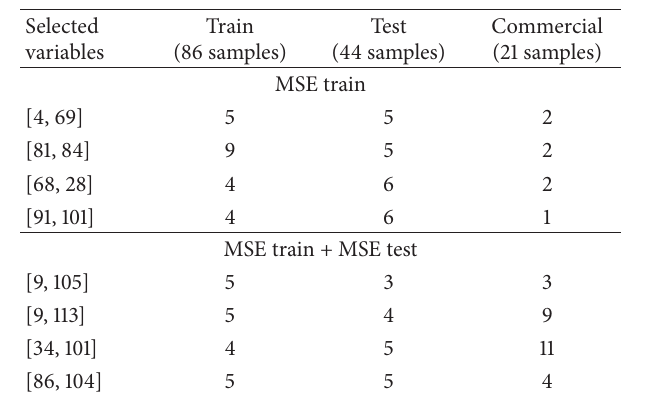
Table12:ClassificationerrorsusingGA+SVM:highconcentration.